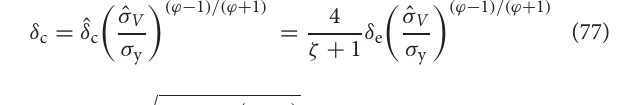
10 and σ y 0.5GPa. = =